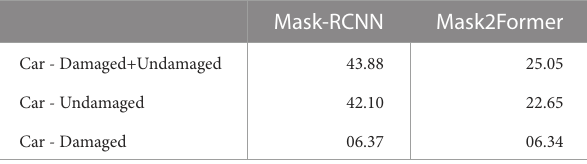
TABLE1 PerformanceintermsofAP’sofoff-the-shelfinstancesegmentation models(withoutfine-tuning)ondifferentvariationsof Car